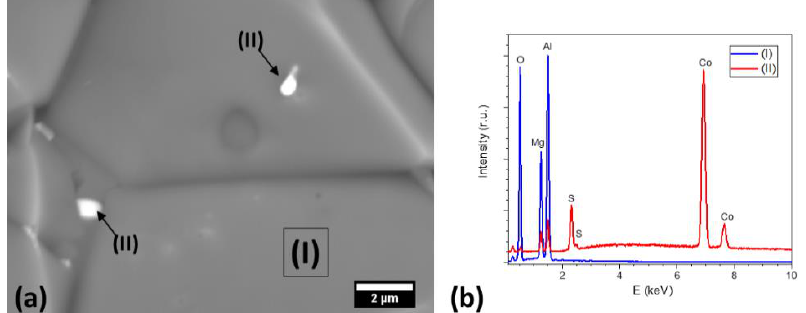
Figure 6. ( a ) Scanning electron micrograph showing in detail bright spots in CoF 2 doped spinel after spark plasma sintering and ( b ) the EDX spectrum of the selected areas/spots: (I), spinel grain and (II), bright spot.